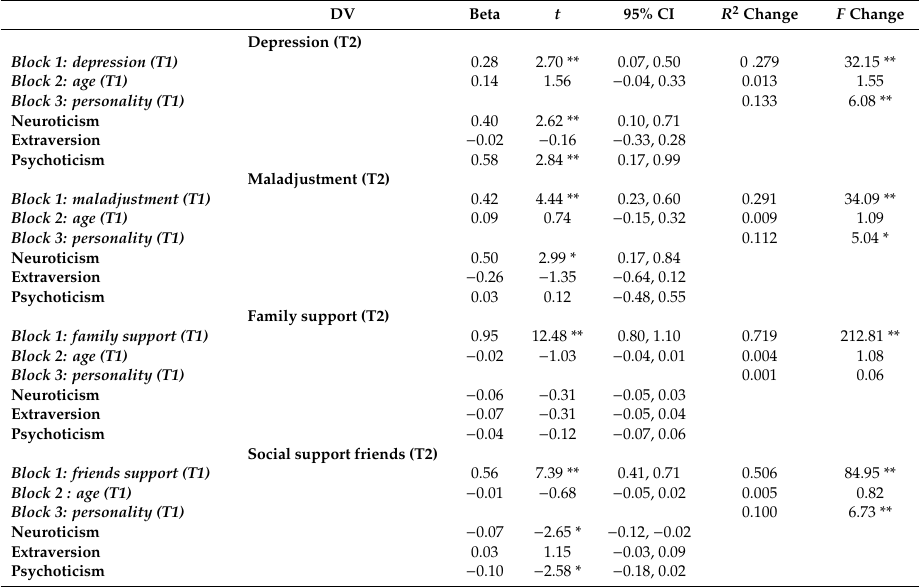
Table 5. Multivariate regression predicting study